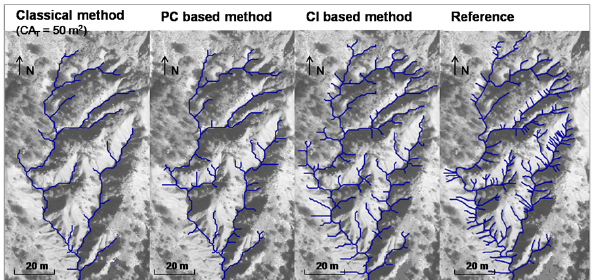
Figure 6. Comparison of thalweg networks obtained using the three methods evaluated in this 2 Fig. 6. Comparison of thalweg networks obtained using the three paper with a reference network of the Moulin catchment test area. 3 methods evaluated in this paper with a reference network of the Moulin catchment test area.